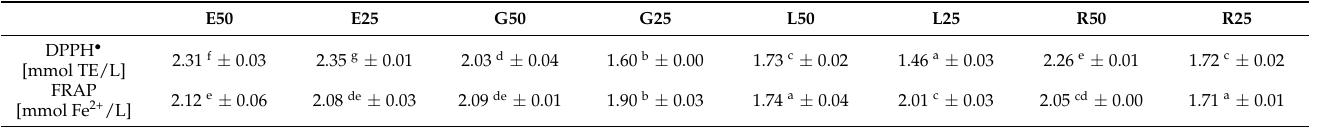
Table 2. Antioxidant activity of Witbier-style